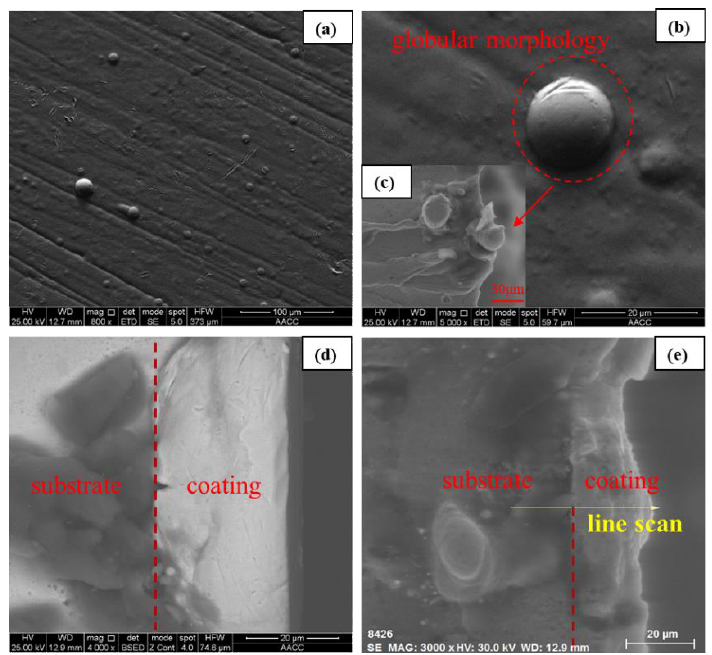
Figure 5. ( a ) Surface morphology of specimen 1 after electroless plating; ( b ) Surface morphology of nickel accumulation; ( c ) Cross-sectional morphology of nickel accumulation; ( d ) Back scattered-electron cross-sectional image of Ni-W-P coating of specimen 1; ( e ) Scattered-electron cross-sectional image of Ni-W-P coating of specimen 1.